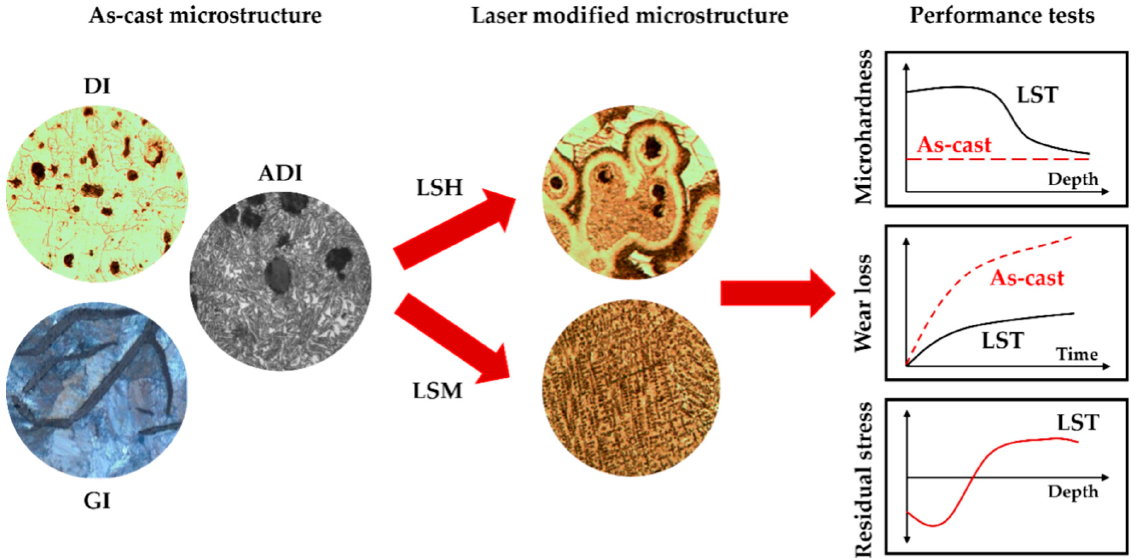
Figure 20. Summarizing diagram of microstructural transformations and overall response of laser- treated cast irons. treated cast